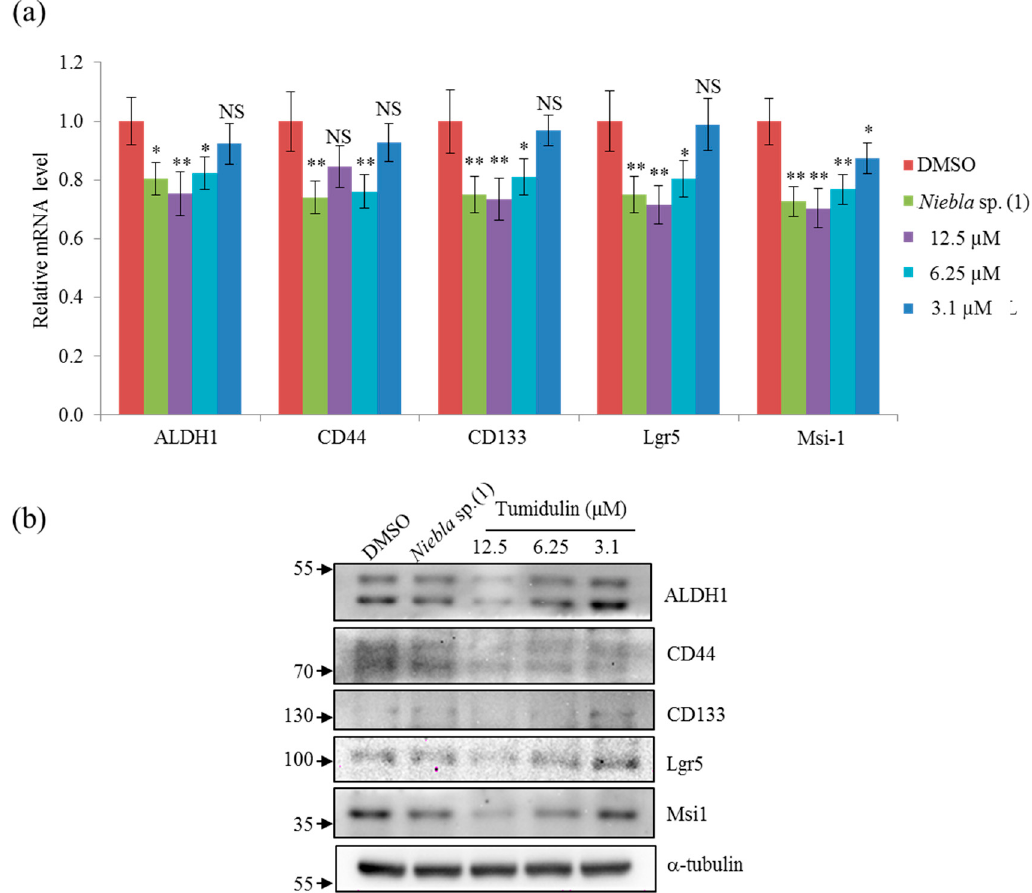
Figure 4. Effects of crude extracts of Niebla sp. (1) and tumidulin on cancer stemness-related gene expression and protein level. CSC221 cells were treated with 5 µg/mL acetone extracts of Niebla sp. (1) or various concentrations of tumidulin for 48 h. ( a ) Quantitative analysis of mRNA expression levels of cancer stem markers aldehyde dehydrigebase-1 (ALDH1), cluster of differentiation 133 (CD133), CD44, Lgr5, and Musashi-1. Data represent mean ± SEM, and analysis was performed by one-way ANOVA. * p < 0.05; ** p < 0.01; NS: no significant difference compared with DMSO-treated CSC221 cells. ( b ) Representative immunoblots are shown with the indicated antibodies.